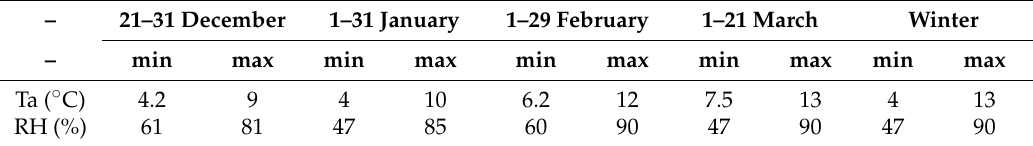
Table 1. Minimum and maximum Ta and RH during the experimental